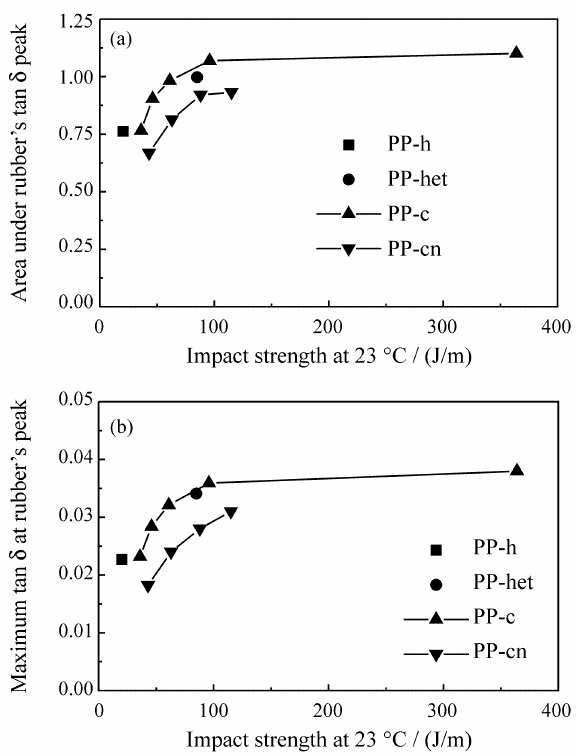
Figure 4. (a) Area under the β damping peak, and (b) its maximum intensity, as a function of the impact strength at room temperature.